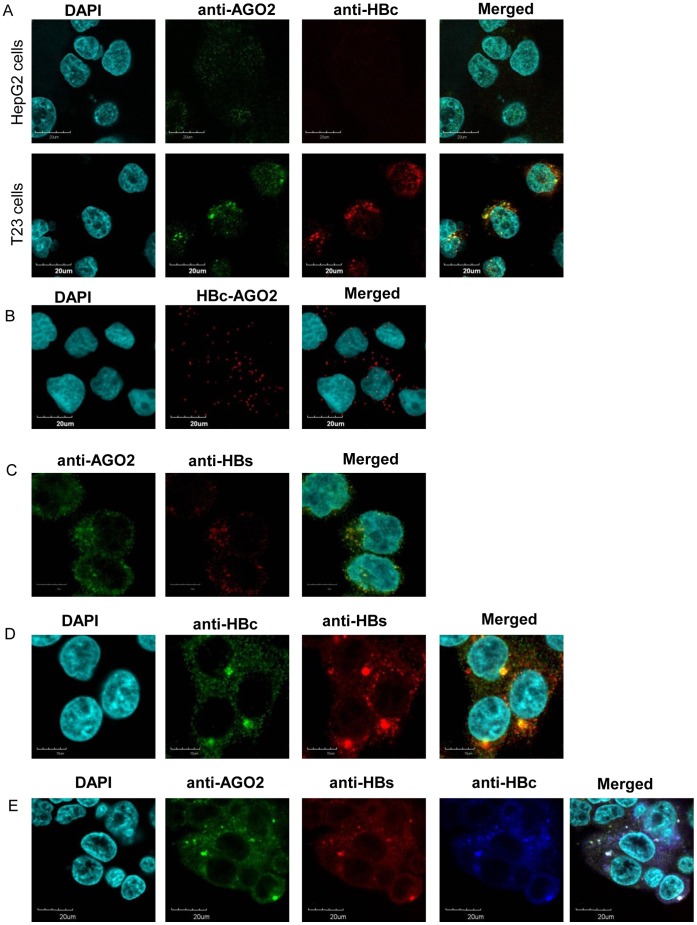
Co-localization of HBcAg and HBsAg with AGO2 in stably transfected T23 cells.A) Anti-AGO2 and anti-HBc staining overlapped in stably transfected T23 cells, but not in HepG2 control cells, suggesting an interaction between HBc and AGO2. B) HBc-AGO2 was detected in T23 but not HepG2 cells using proximity ligation assays (PLA), suggesting a protein-protein interaction between HBcAg and AGO2. C) Overlap of anti-AGO2 and anti-HBs staining suggests co-localization of HBs and AGO2. D) Anti- HBc, and anti-HBs staining overlapped in T23 cells, which may indicate that HBc and HBs co-localize. E) Overlap of anti-AGO2, anti-HBc, and anti-HBs staining in T23 cells suggests that all three proteins may co-localize.